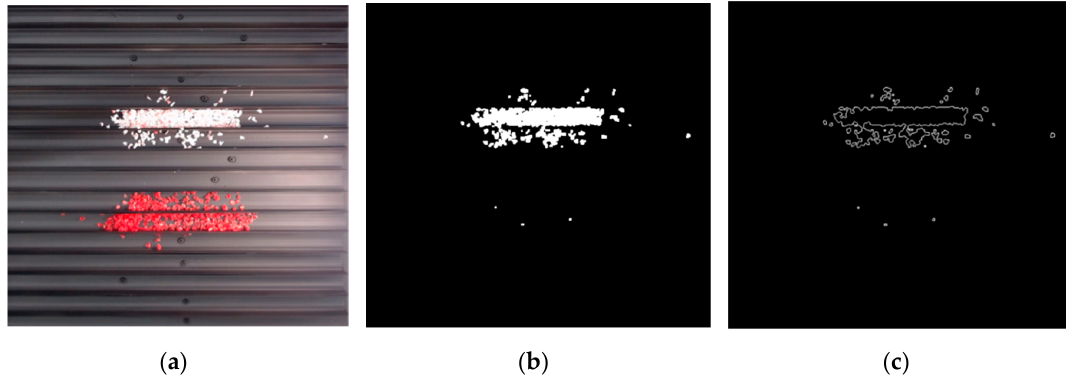
Figure 6. Raw image ( a ), effect of filtration ( b ) and calculated dispersion ( c ) for determined ranges of HSV parameters for PS.